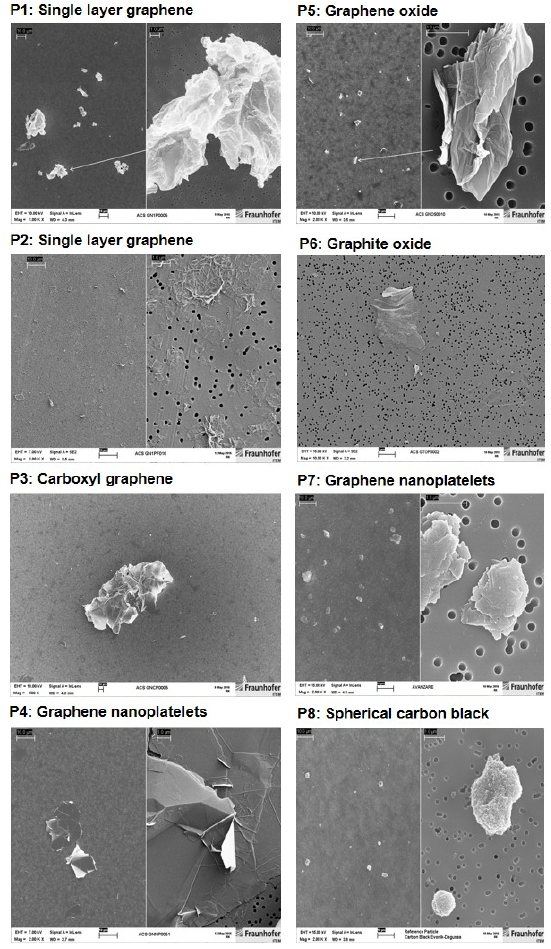
Figure 1. Scanning electron microscopic (SEM) pictures of the GRNP materials P1–P8, dispersed by sonication in cell culture medium with 10% FCS. Magnifications used for the split pictures were as follows, left: 1000–2000 × ; right: 20,000–50,000 × . For the P3, a magnification of 500 × was used, and for P6, a magnification of 10,000× was used.